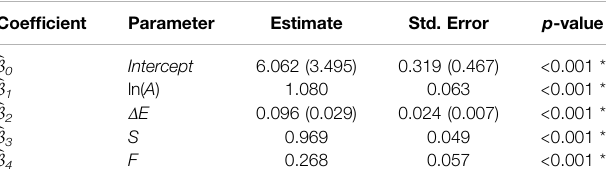
TABLE7| Parameterestimate,standarderror,and p -valueformultipleregression model 5 m. Coef fi cient